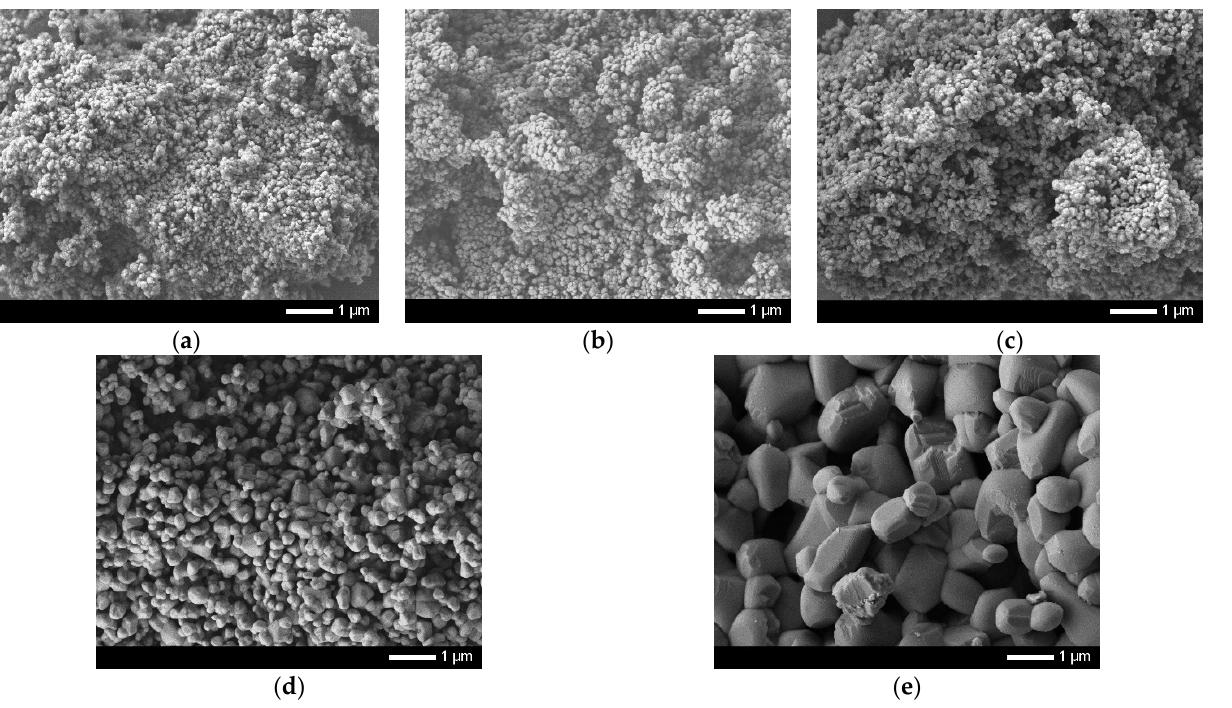
Figure 1. SEM images of synthesized ceramics: ( a ) pristine; ( b ) 400 ° С ; ( c ) 600° С ; ( d ) 800 ° С ; ( e ) 1000 ° С .